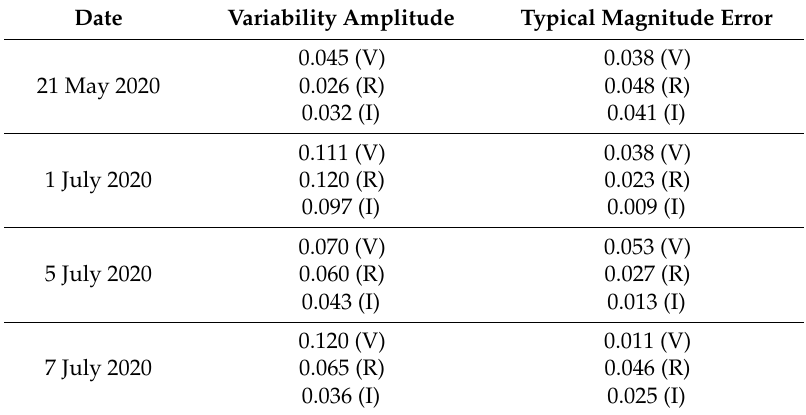
Table 4. Table of amplitudes and measurement errors (in fractions of magnitude) for observation session of 3C 371 source, performed at the Vihorlat observatory, on 21 May and 1, 5, 7 July